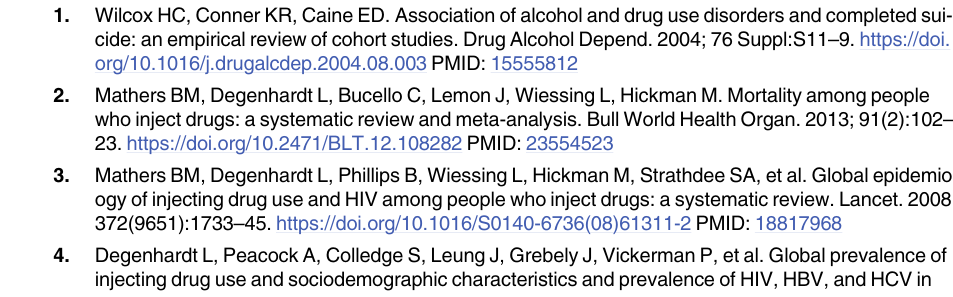
S3 Fig. Rankogram of the preference of treatment options with respect to the retention outcome. S4 Fig. Surface under the cumulative ranking (SUCRA) score diagram for the retention outcome. S5 Fig. Confidence in network meta-analysis (CINeMA) risk of bias contributions for each pairwise comparison based on RoB 2. S6 Fig. Confidence in network meta-analysis (CINeMA) indirectness contributions for each pairwise